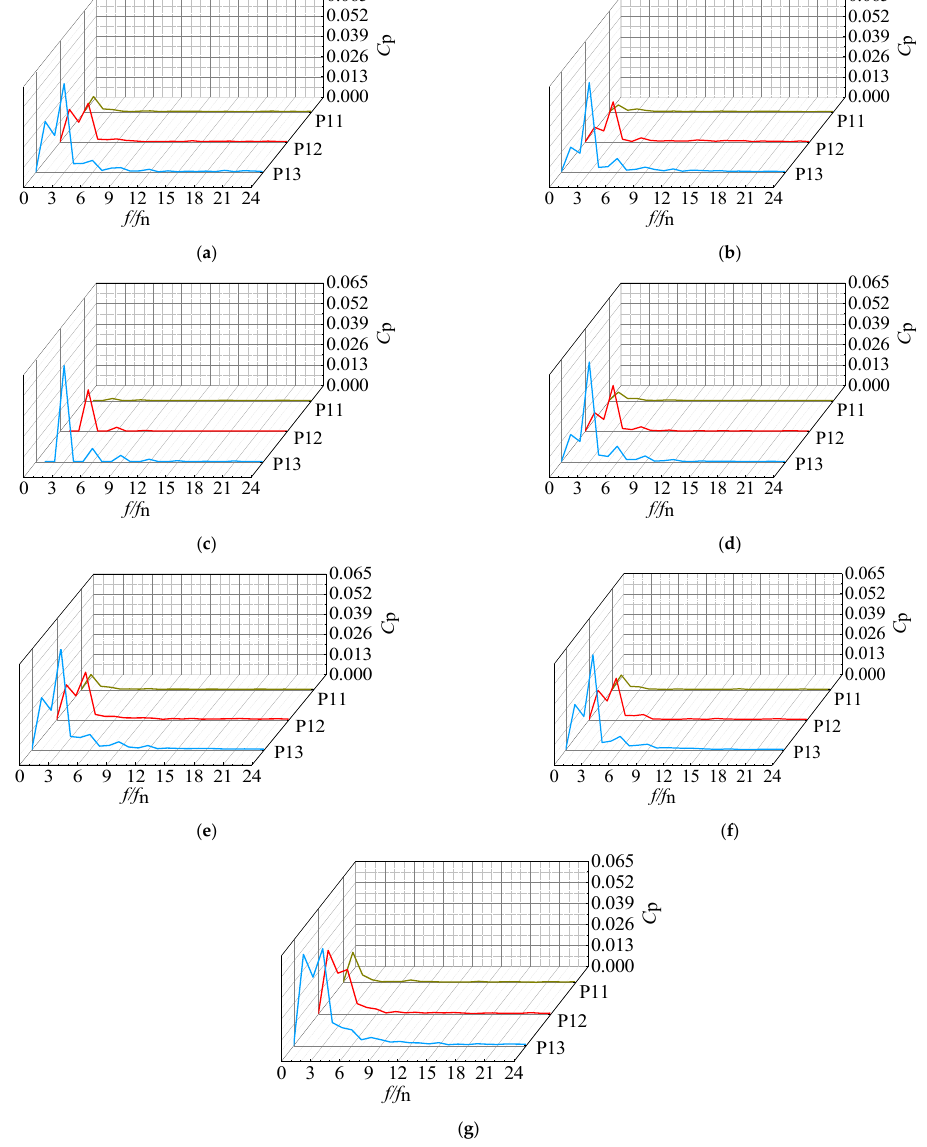
Figure 13. Frequency-domain diagrams of the pressure fluctuations at the impeller inlet: ( a ) Design Scheme I; ( b ) Design Scheme II; ( c ) Design Scheme III; ( d ) Design Scheme IV; ( e ) Design Scheme V; ( f ) Design Scheme VI; and ( g ) Design Scheme VII.